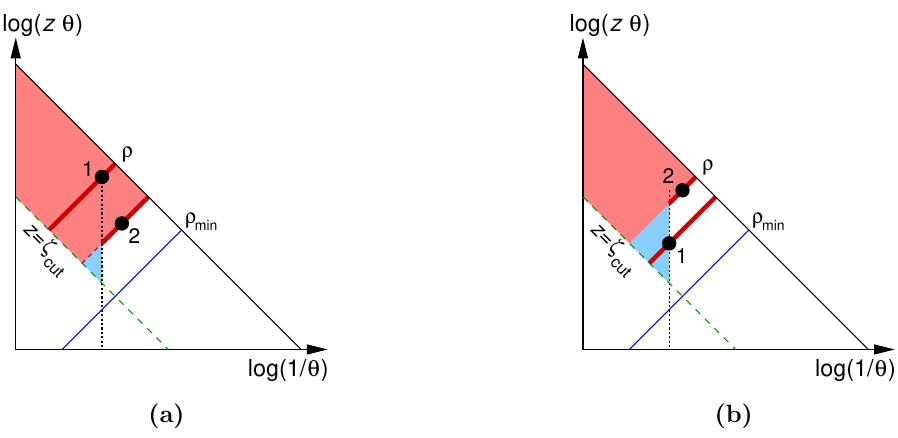
Figure 3. Lund plane corresponding to the TopSplitter tagger. Emissions are labelled such that emission 1 is the (cid:12)rst one selected by the tagger, i.e. (cid:18) 1 (cid:29) (cid:18) 2 , and emission 2 dominates the prong mass. The two plots correspond to (a) (cid:26) 1 (cid:29) (cid:26) 2 and (b) (cid:26) 1 (cid:28) (cid:26) 2 . The red shaded region shows the veto region for emissions with z > (cid:16) cut and (cid:26) > (cid:26) 2 while the blue shaded triangle region corresponds to the extra contribution that arises from requiring that there are also no emissions with (cid:18) > (cid:18) 1 and z > (cid:16) cut